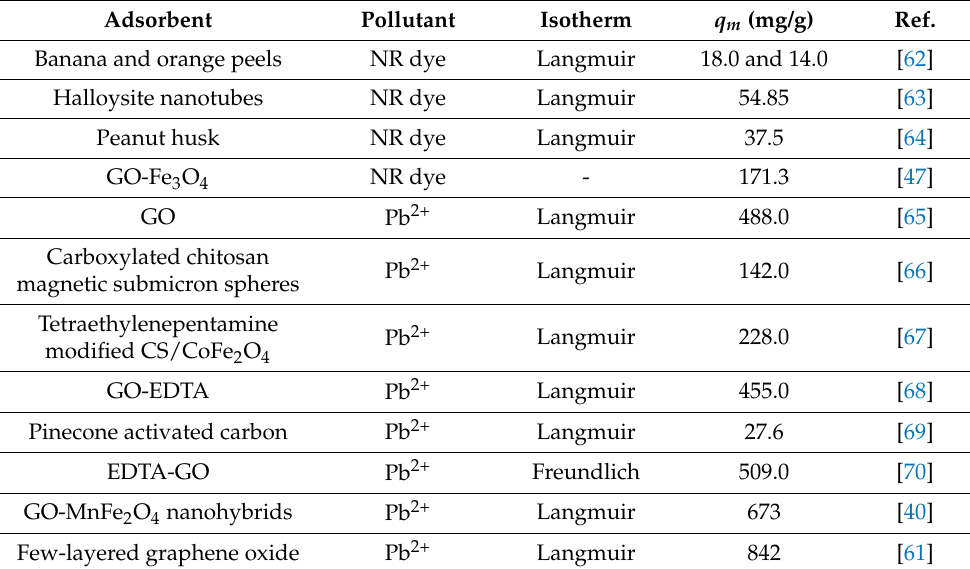
Table 2. Reported adsorbents for adsorption of Pb 2+ ions and NR